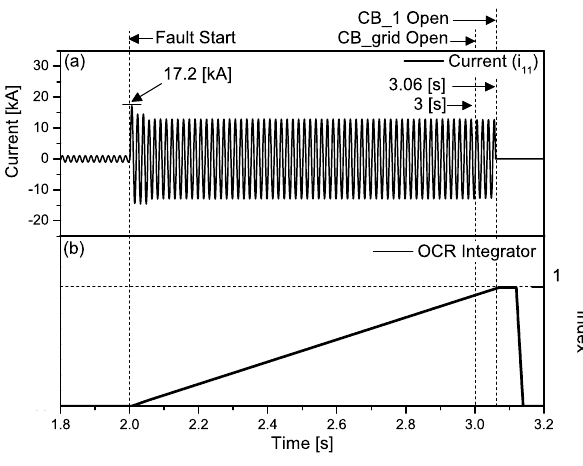
Figure 13. Feeder current ( i 11 ) and trip signal of the OCR ( OCR 1 ) with an SFCL.